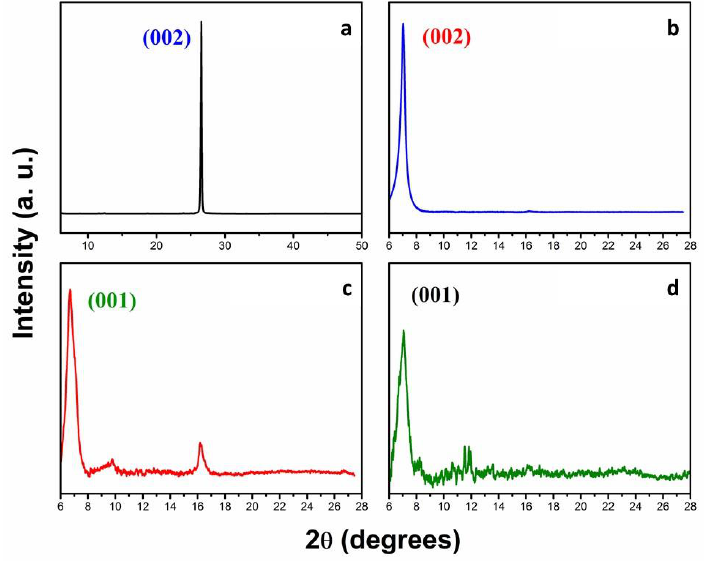
Figure 3. X-ray di ff raction (XRD) pattern. ( a ) Graphite, ( b ) GO1, ( c ) GO2, ( d ) GO3. Figure 3. X-ray diffraction (XRD) pattern. ( a ) Graphite, ( b ) GO1, ( c ) GO2, ( d ) GO3.